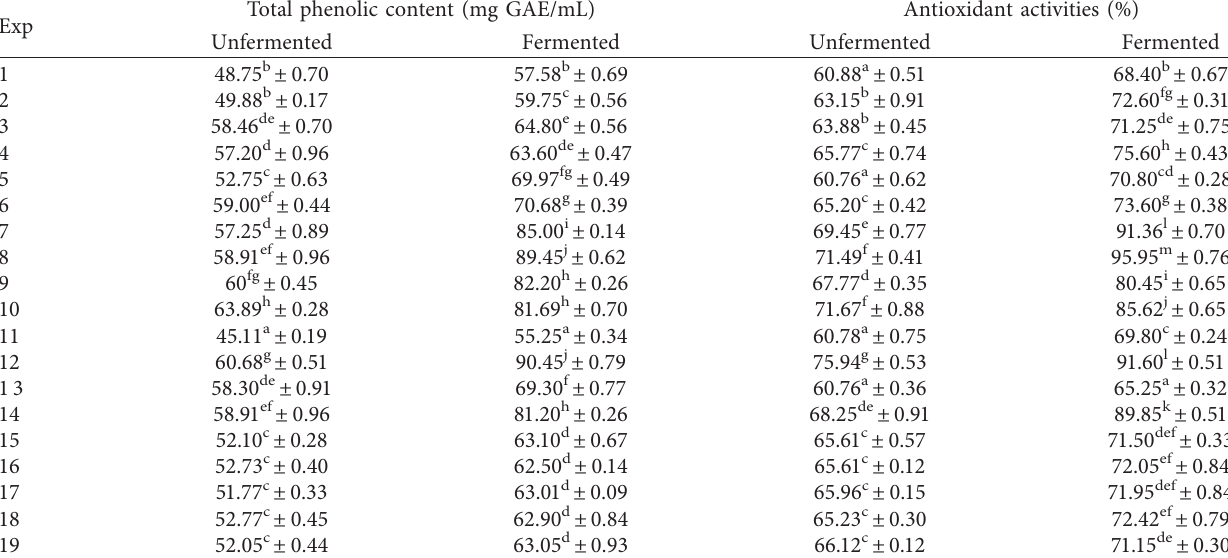
Table 5: Levels of total phenolic content and antioxidant activities before and after fermentation for each beverage.